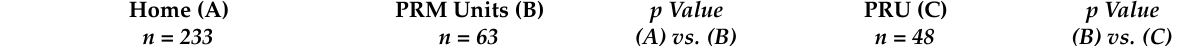
Table 2. Clinical presentation, biology results, and treatment of patients according to discharge destination.